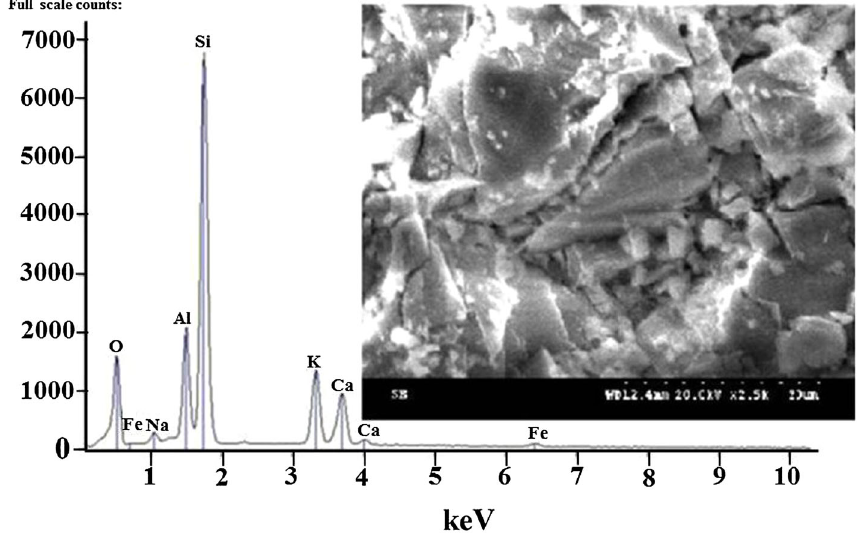
Fig. 6 SEM analysis for FRL5.